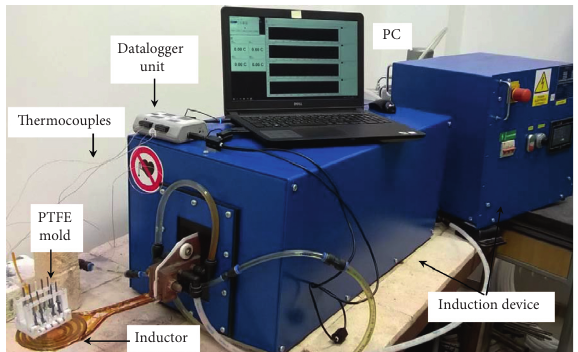
Figure 1: Experimental setup of soldering by induction heating.